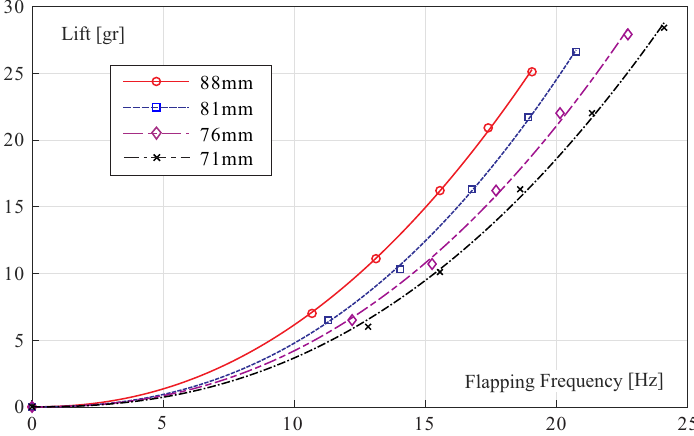
Figure 5. Lift L vs. flapping frequency f for the various wings of Figure